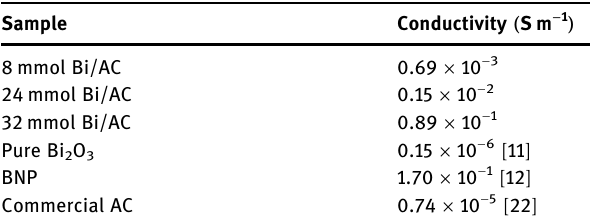
Table 3: The conductivity values measured from the EIS test